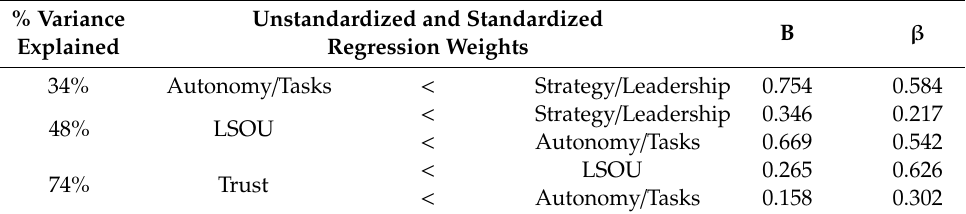
Table 5. Regression weights and predictions.